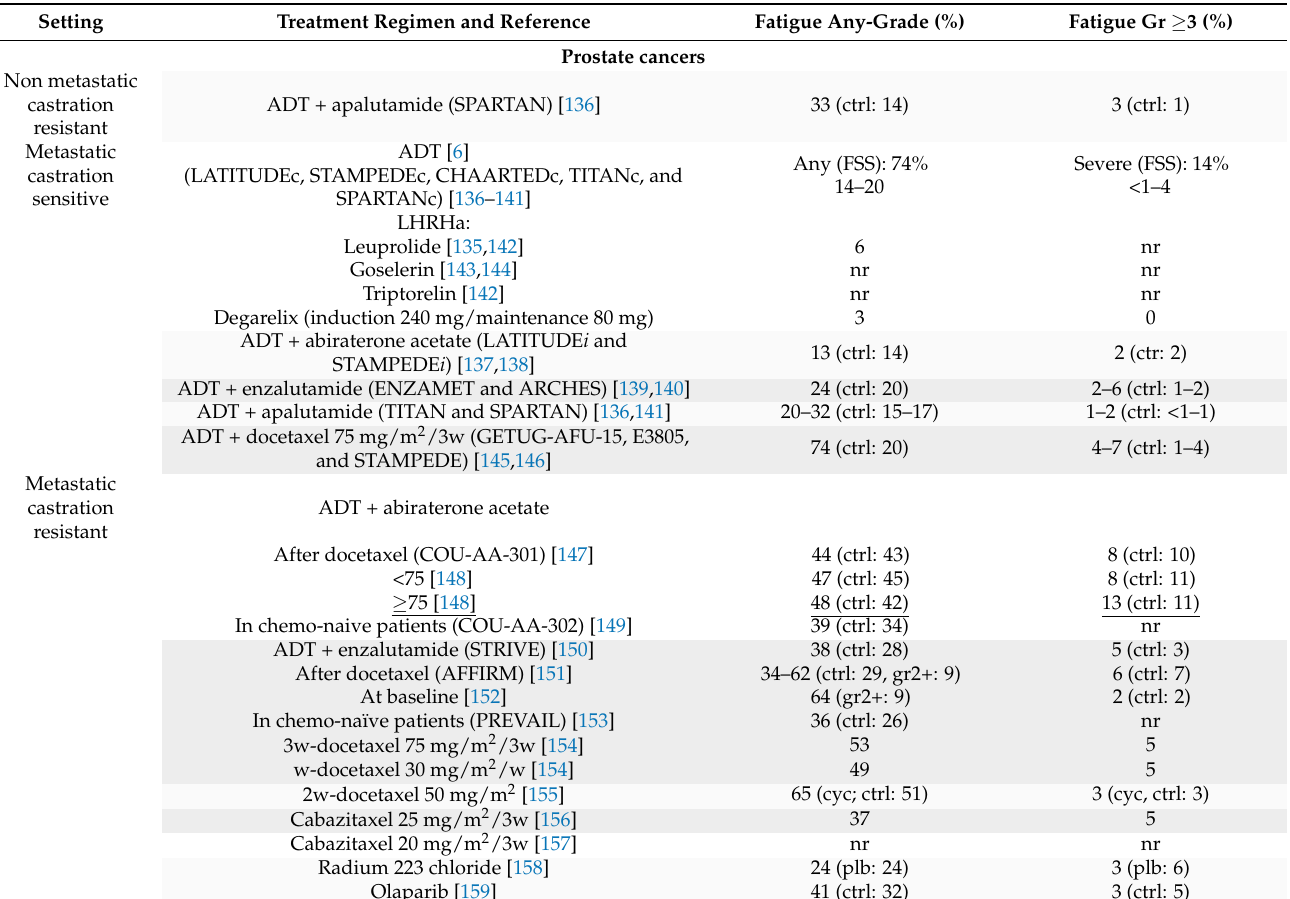
Table 3. Fatigue events in the most common anticancer regimens for prostate and urothelial cancers. Abbreviations: ADT: androgen deprivation therapy; ctrl: control; DDGc: dose dense with G-CSF; gr: grade; gr2+: grade 2 or over; LHRHa: LHRH analog; nr: not reported; (2/3)w